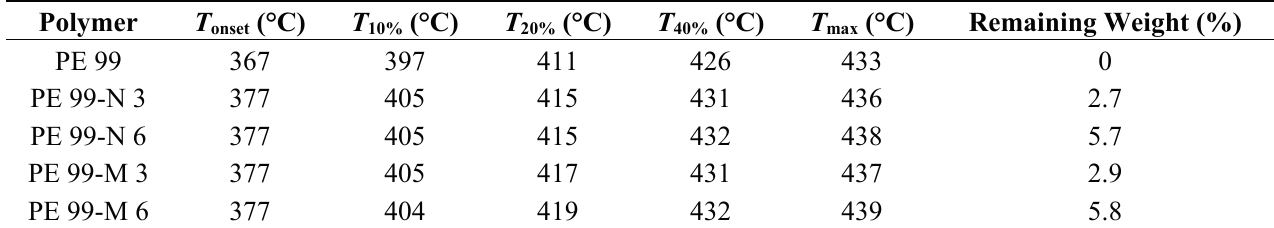
Table 2. Characteristic TGA temperatures and remaining weight percentages for the decomposition of the studied micro-molded